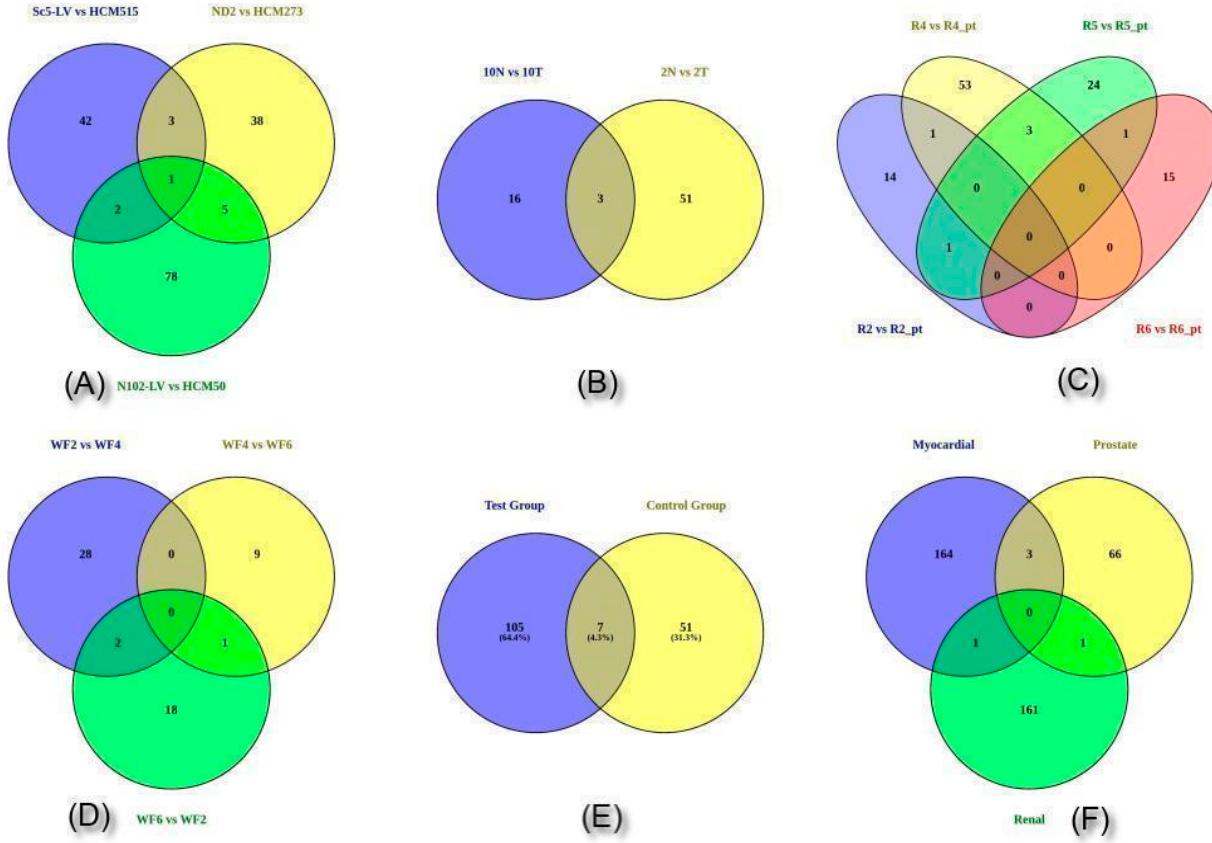
Figure 2. Differentially expressed genes between control and treated in all three datasets, viz., ( A ) (control and treated) myocardial, ( B ) (control and treated) prostate, and ( C ) test (treated) group of renal data; ( D ) control group of renal data, ( E ) control and test group of renal data, and ( F ) common in all three, myocardial, renal and prostate data.